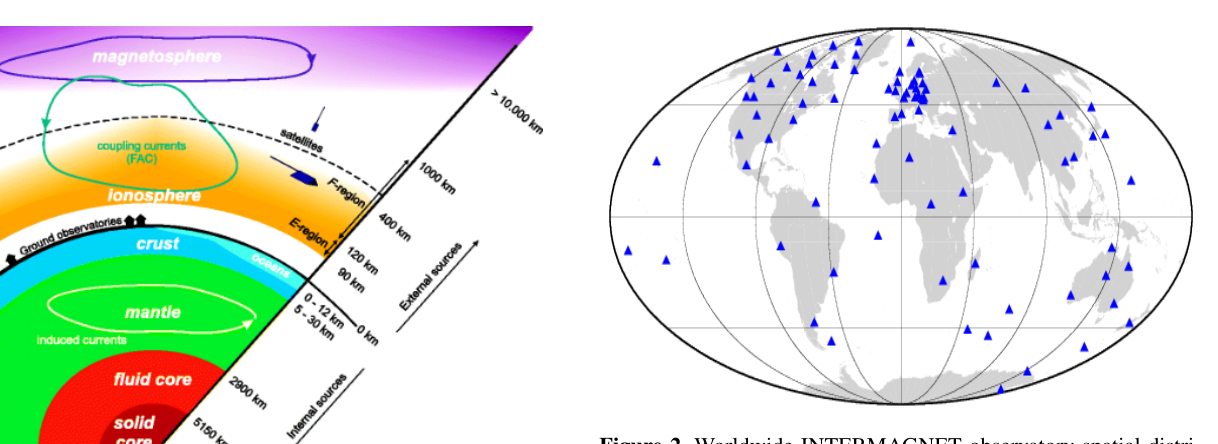
Figure 2. Worldwide INTERMAGNET observatory spatial distri- bution that provided hourly-mean measurements used in the